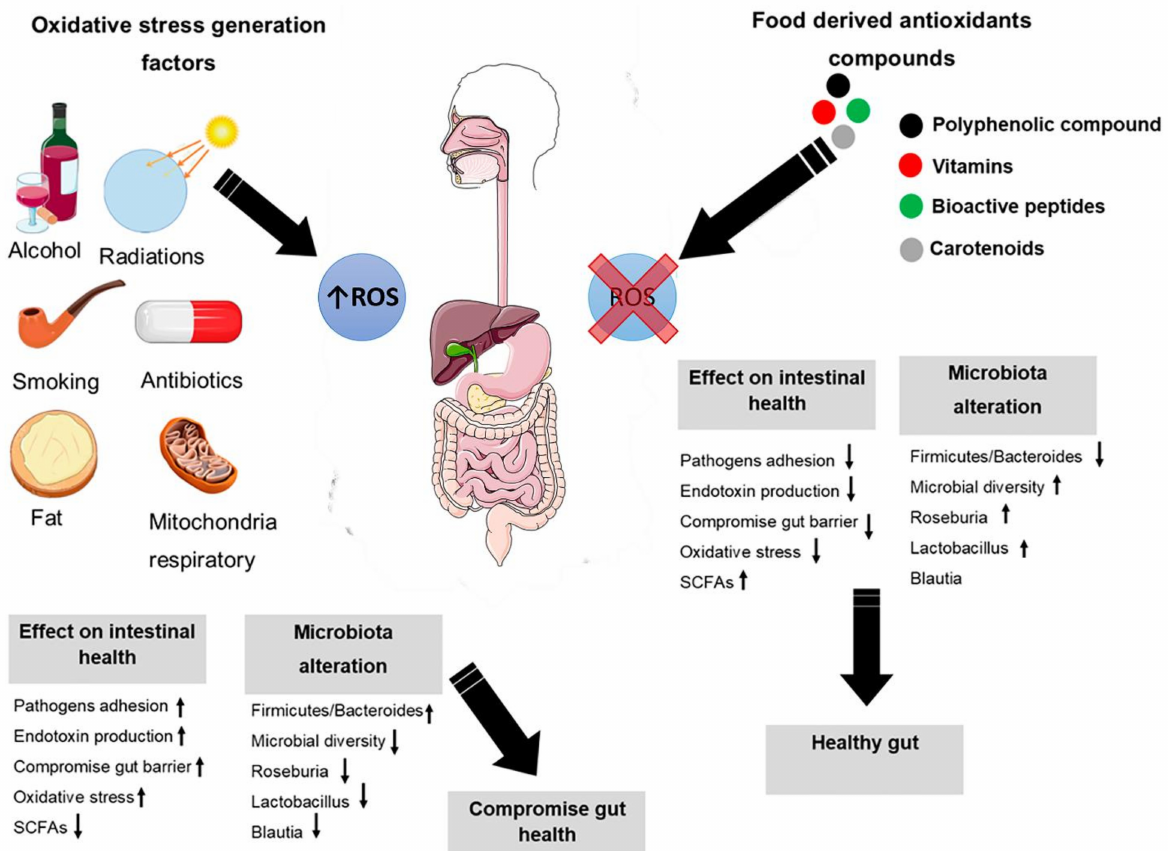
Figure 3. ROS production impact on the homeostasis of host gut. In balance stage, there is a relationship between gut, gut microbiota, and ROS which maintain the function host immune and mucosal defense. In imbalance stage, the over- production of ROS induces oxidative stress which leads to dysbiosis in gut microbiota. The image was created by using the service provide by Servier Mediacl Art under license Creative Common Attribution 3.0 France. ↑ : Increase; ↓ :